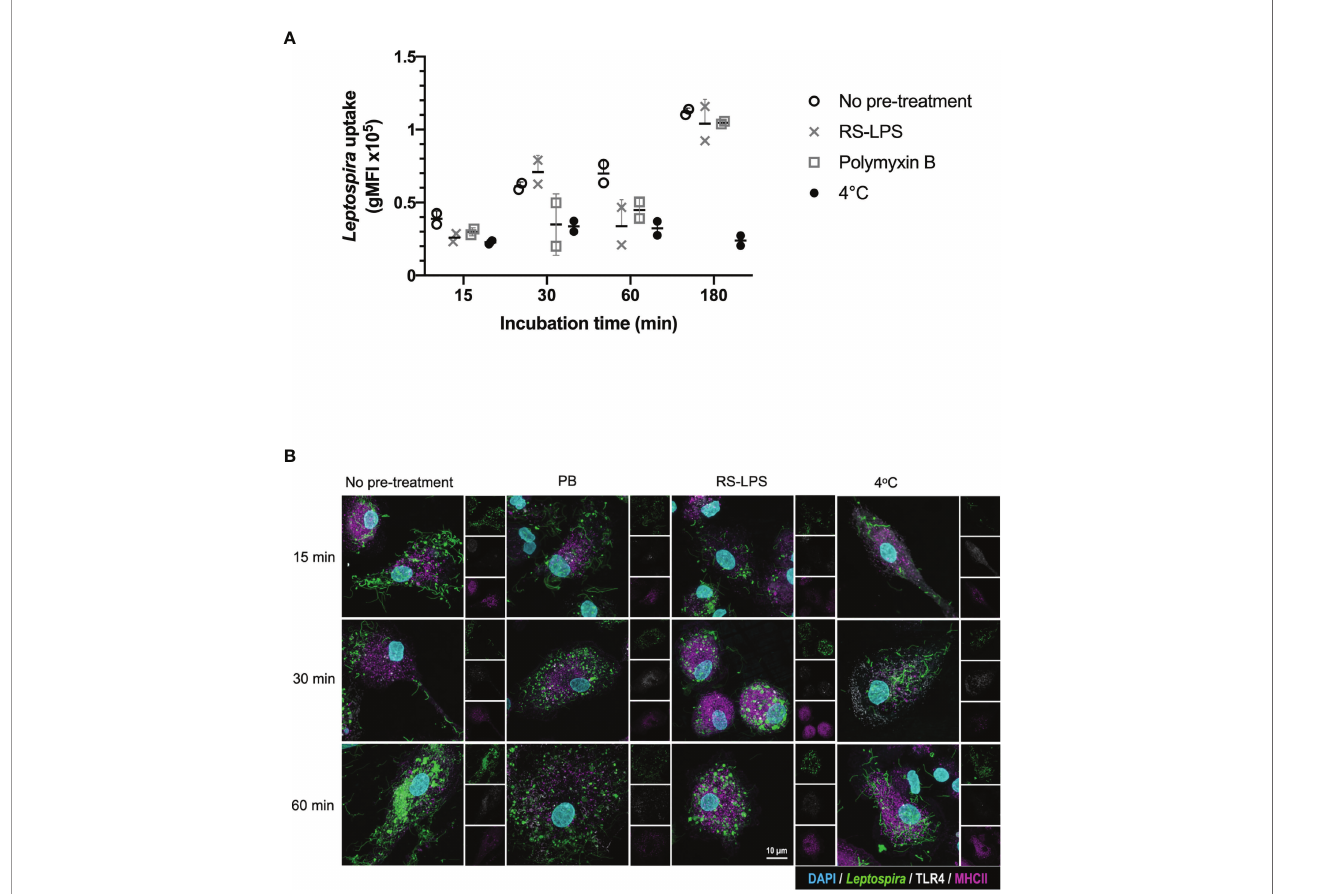
FIGURE 3 | TLR4 signaling is involved in the uptake of inactivated Leptospira in canine moDC. MoDC were incubated with Atto 488-labeled inactivated Leptospira for 15, 30, 60 or 180 min at 37°C or 4°C. In addition, moDC were pre-treated with RS-LPS or stimulated with Leptospira that were pre-incubated with polymyxin B. The experiment was performed using two replicates per condition. (A) Leptospira uptake was determined by fl ow cytometry as an increase in Atto 488 geometric mean fl uorescence intensity (gMFI) in the MHC II positive gate. The uptake of untreated (open circle), RS-LPS (cross) or polymyxin B (square) pre-treated sample or uptake at 4°C (closed circle) is shown. (B) moDC were stained with mouse anti-canine MHC II (magenta) and cross-reactive mouse anti-human TLR4 (white) to visualize bacterial uptake by confocal microscopy. Fluorescent Leptospira are shown in green. 4 ′ ,6-Diamidino-2-phenylindole (DAPI) (blue) was used to stain the nuclei. 3D images were constructed from stack series with 150 nm step